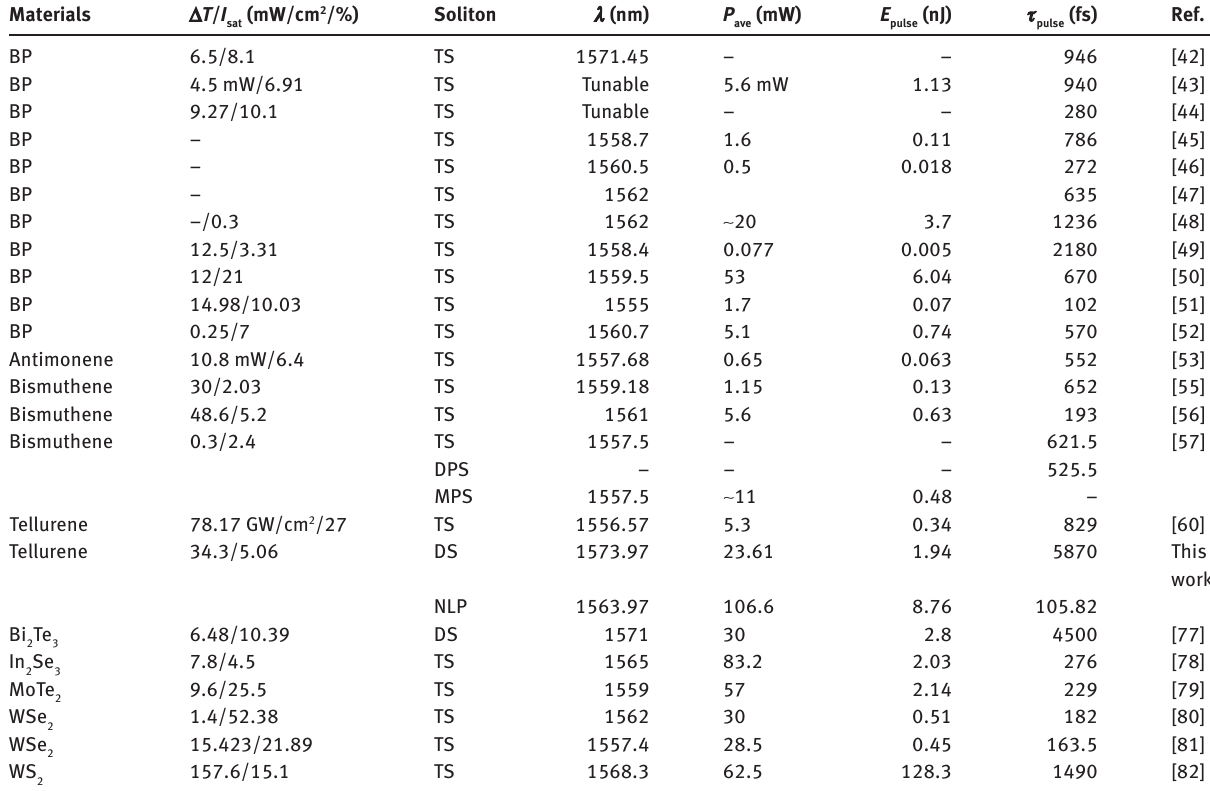
Table 1: Comparison of Xenes-based mode-locked fiber lasers.